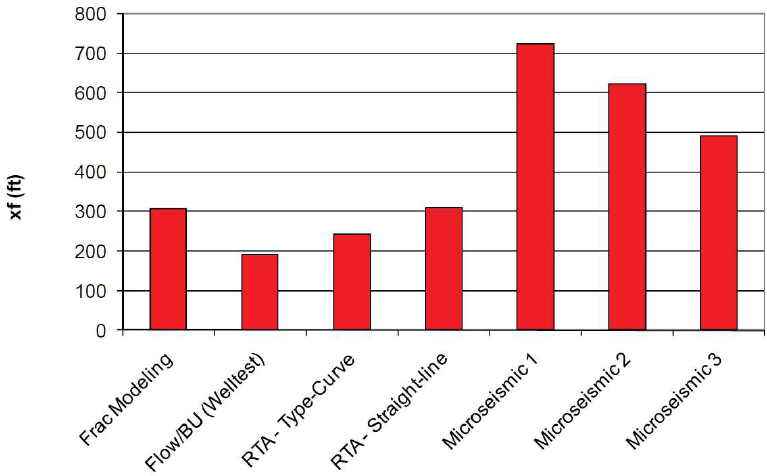
Figure 7. Comparison of fracture half-lengths (xf) derived from various sources [41] . Reproduced from [41], Clarkson: 2011.